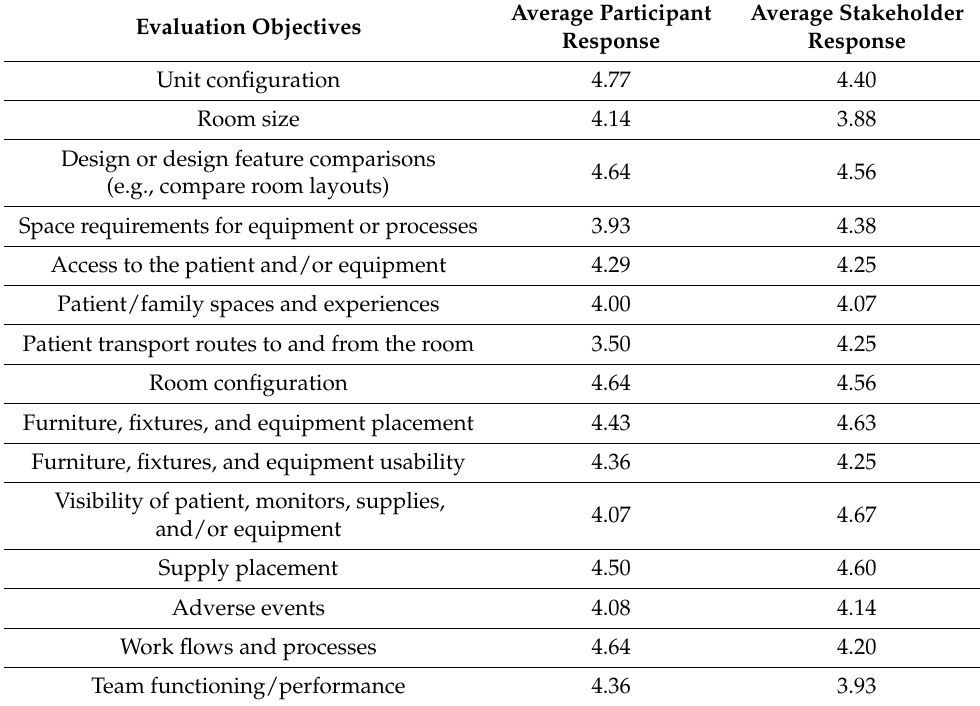
Table 2. Survey responses from scenario enactment participants and hospital design